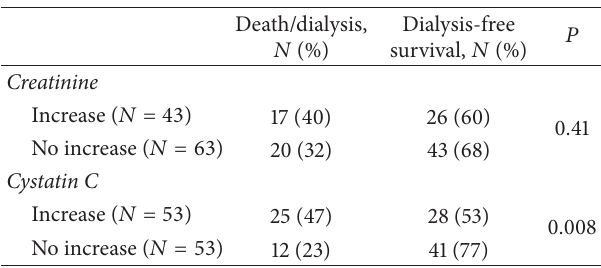
Table 2: Association between increasing filtration markers and the primary